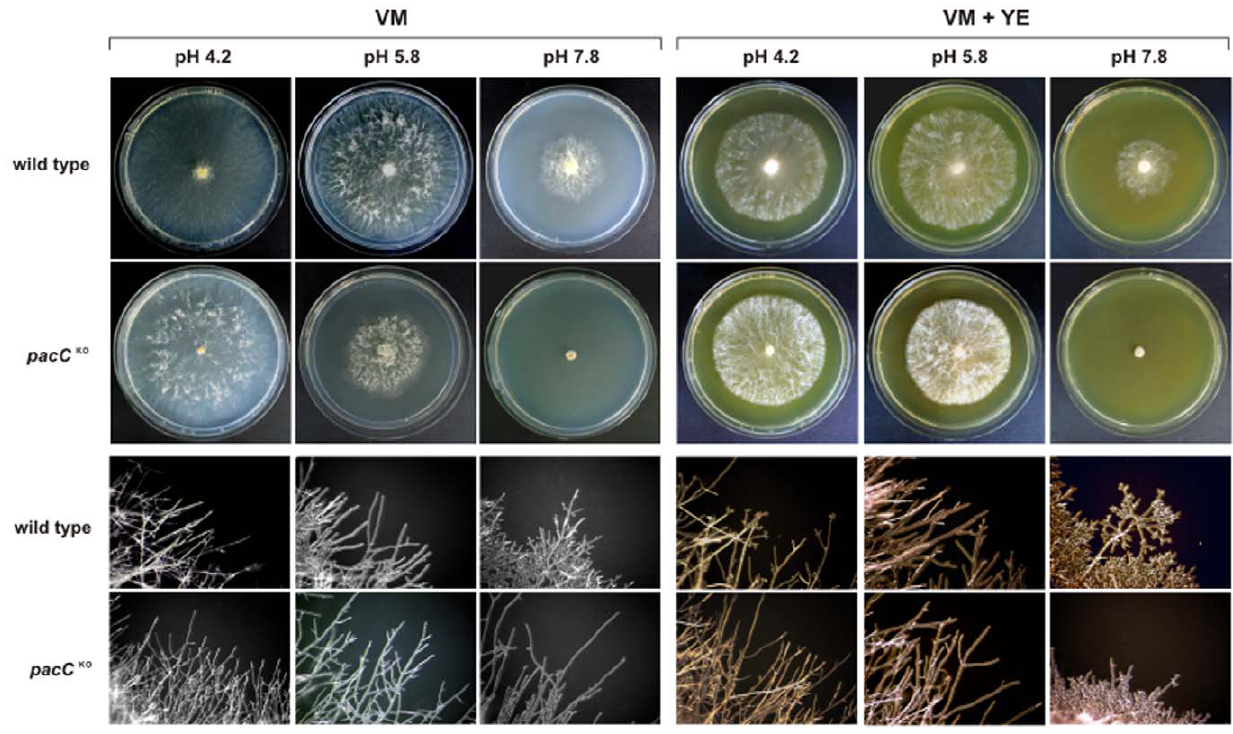
Figure 2. Phenotypes of the wild-type and pacC KO strains in different pH and nutritional growth conditions. The strains (10 7 conidia/ mL) were cultured on plates containing agar VM medium and VM medium supplemented with yeast extract (VM + YE) at pH 4.2, 5.8 and 7.8, in ambient light/dark for 24 h. Hyphae at the colony edge were observed using a stereoscope.